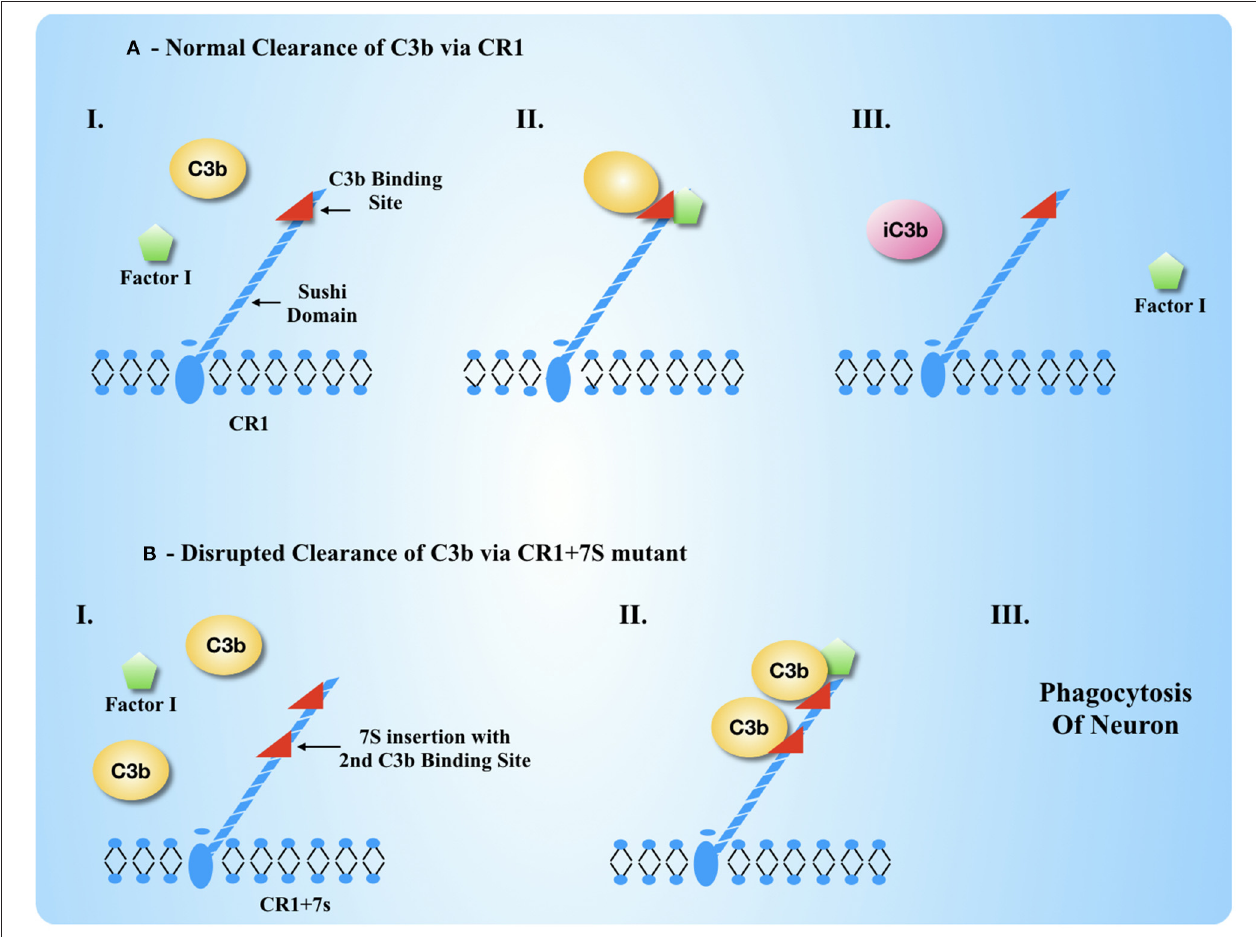
FIGURE 5 | CR1 Biology with anticipated changes due to duplicated sushi domains in CR1 biology normally and under dysregulation. (A) Under normal circumstances, CR1 acts as a cofactor to Factor I to cleave C3b into iC3b, which is released so that another C3b may be bound and cleaved. (B) Mutant CR1 with a second C3b binding site (CR1 + 7S) is unable to release the C3b dimer because the dimer may bind more tightly. The result is that the cell with this CR1 + 7S on the surface is incorrectly tagged for phagocytosis or